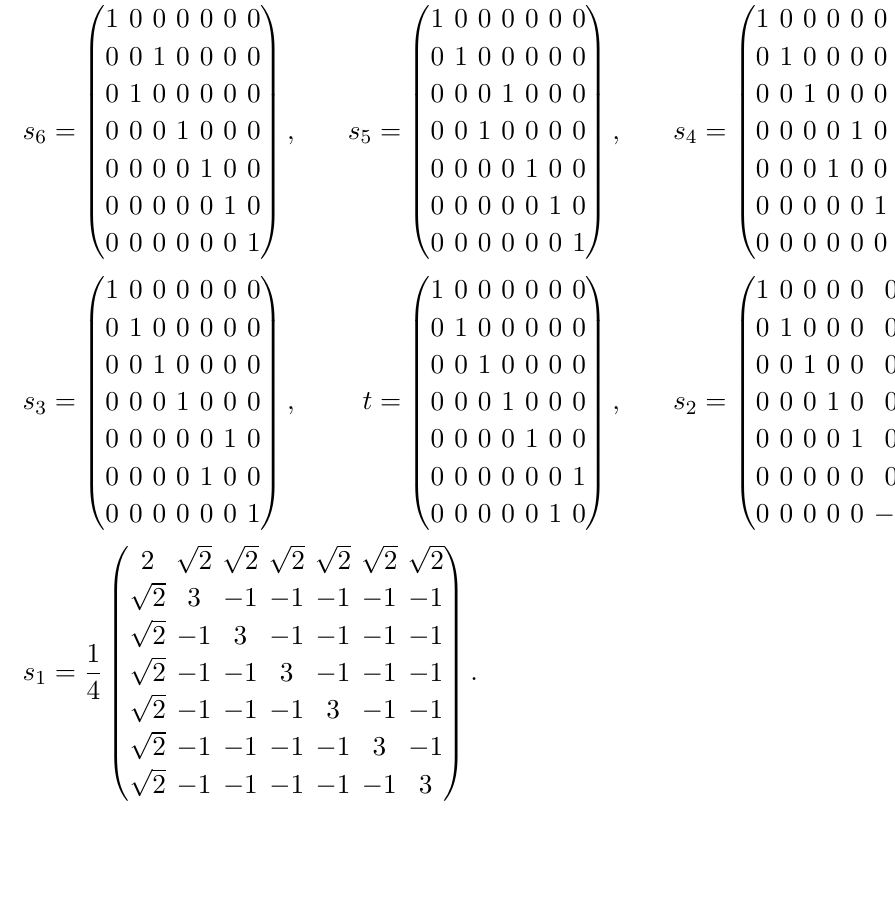
, this structure can be repre- i coordinates, represented in terms of the i